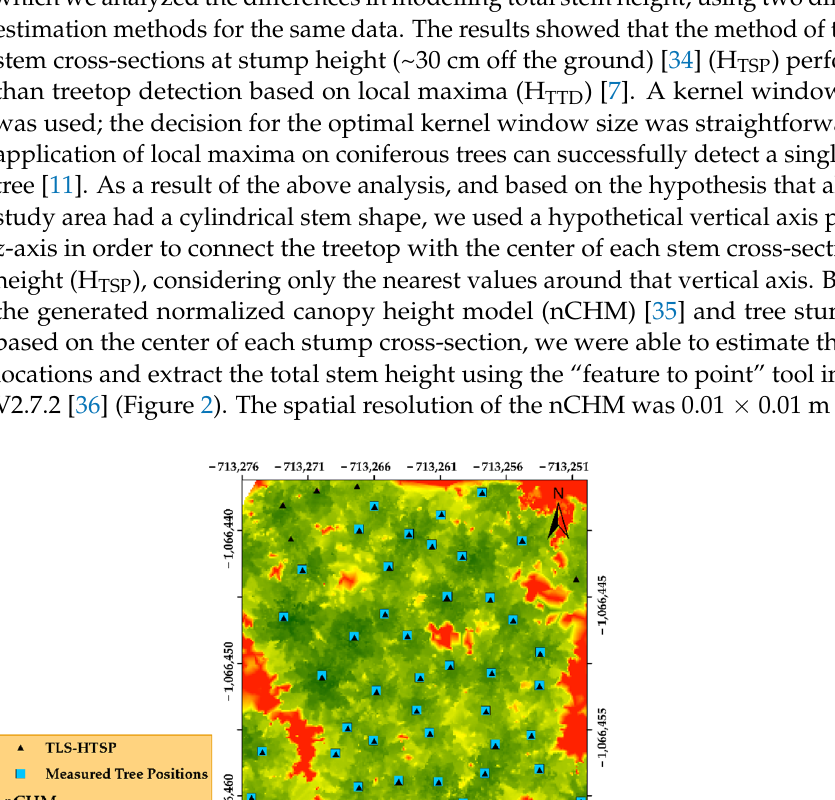
Table 1. Trimble TX8 terrestrial laser scanning device specifications.